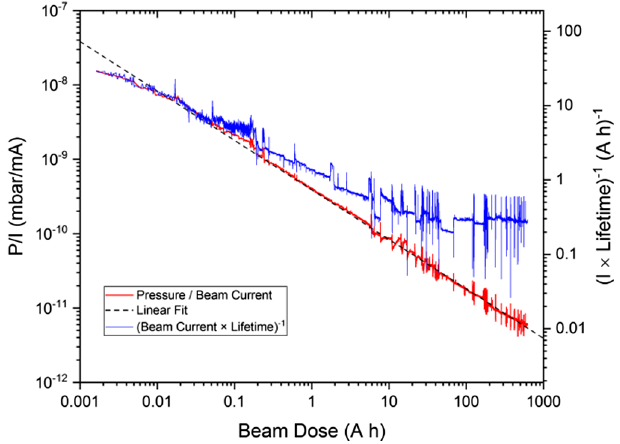
16. Dynamic vacuum pressure averaged over the cell (red), P/I where P is the pressure and I is the beam current; electron loss rate normalized to current (blue) following the DDBA installation